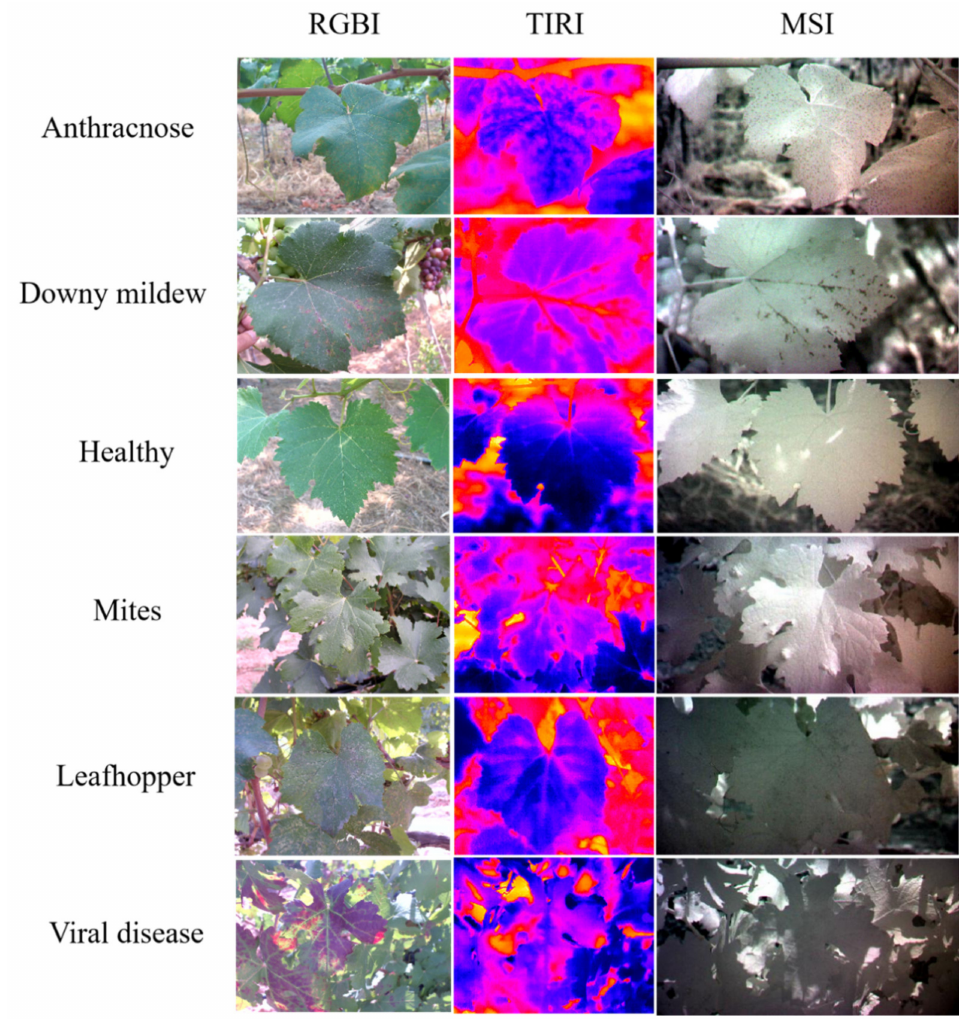
Figure 2. RGBI, TIRI, and MSI of six representative grape foliage diseases and